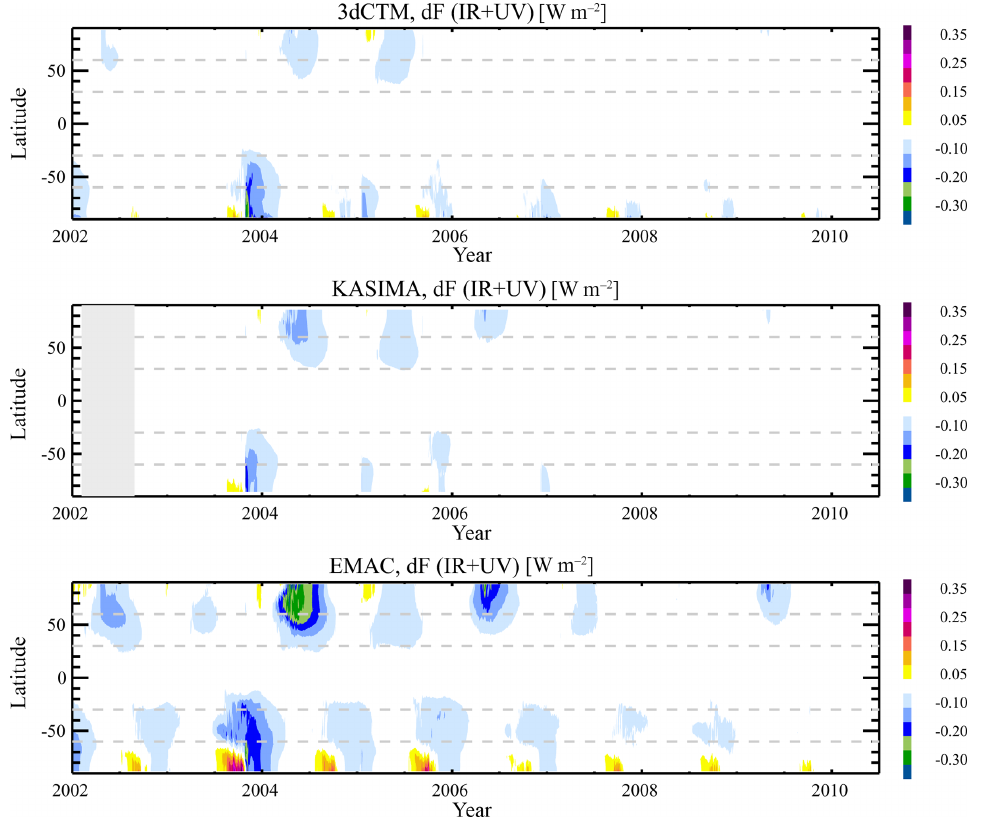
Figure 16. Daily changes in the net amount of energy absorbed or transmitted due to particle-induced ozone destruction in the stratosphere (Wm − 2 ), derived from the difference of model runs with model runs without particle forcing, as a function of time and latitude.